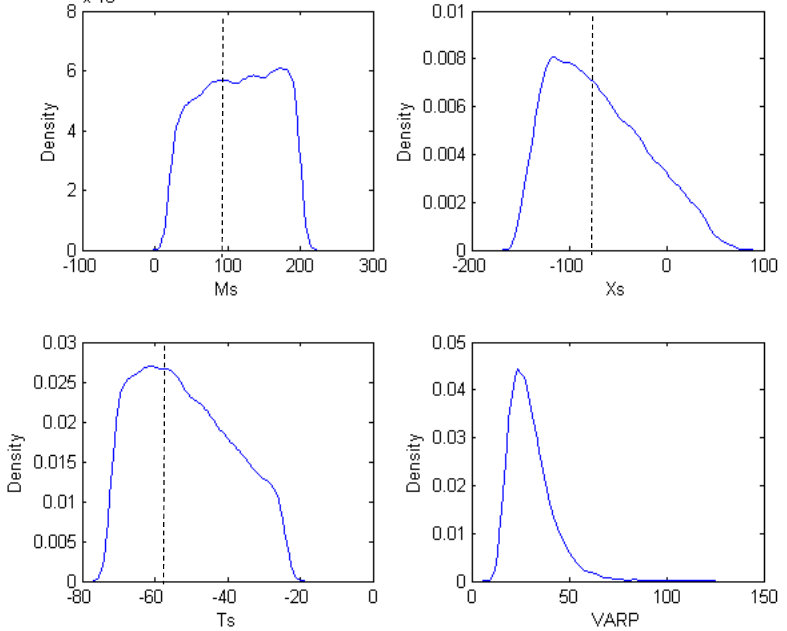
Figure 6. Posterior probability density functions with assumptions of heteroscedastic errors (Run 2). Dashed lines denote the real values.